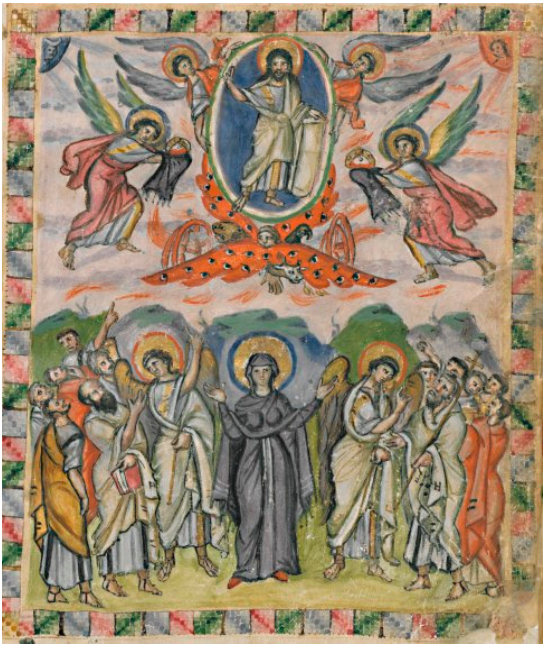
Figure 12. Rabbula Gospels from the 6th century (Florence, Laur., Plut. 1. 56, c.13v). © Biblioteca Medicea Laurenziana (with kind permission).